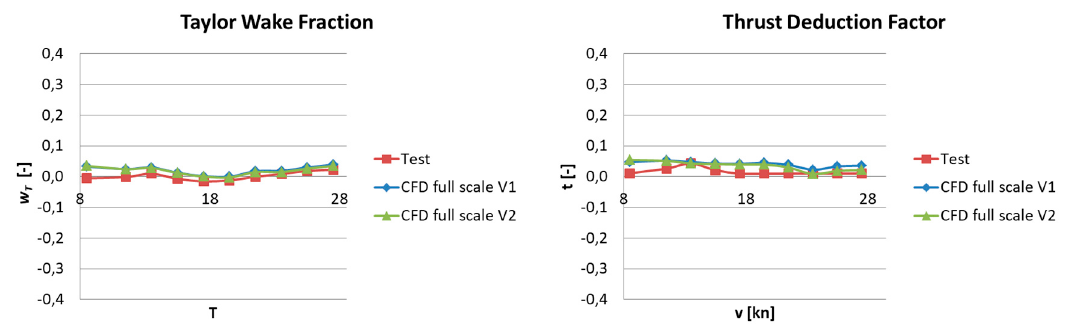
Figure 13. Taylor wake fraction ( left ) and thrust deduction factors ( right ) from model tests and full scale CFD (two analysis methods) for the Stavanger